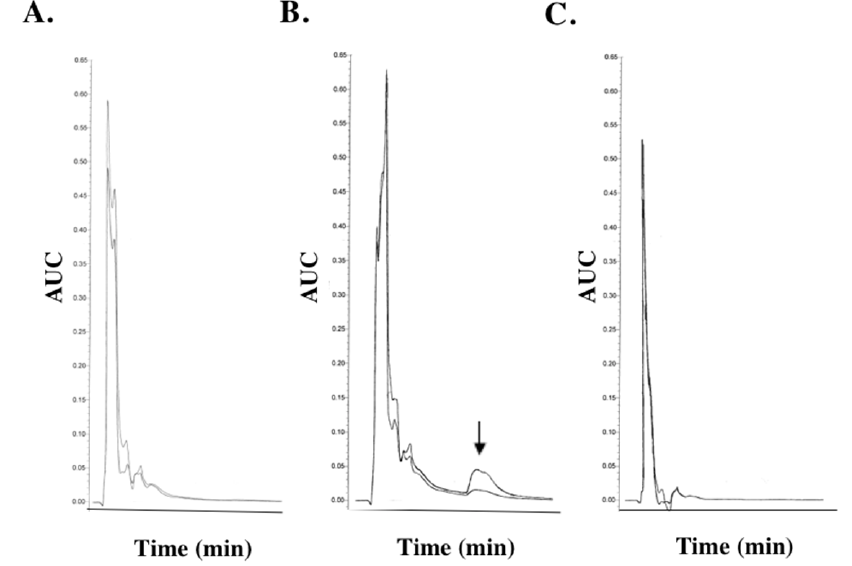
Figure 2. Absorbance (254 and 280 nm) of the formic acid extracted nucleotide pool of log-phase S. aureus ATCC 29213 after 20 min with either ( A ) no treatment, ( B ) 60 µ g/mL mupirocin, or ( C ) 16 µ g/mL SK-03-92. Arrow denotes the (p)ppGpp peak.